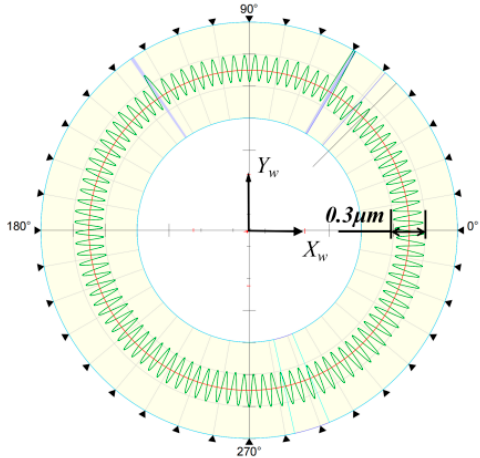
Figure 11. Circumferential tool pattern of the workpiece.